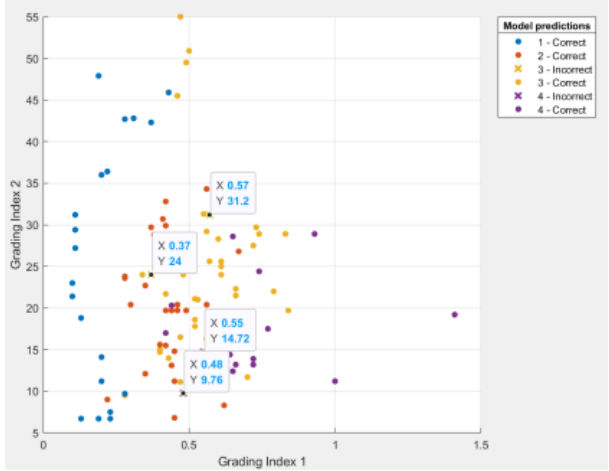
Figure 5. Scatter diagram of prediction results in low dimension (1).